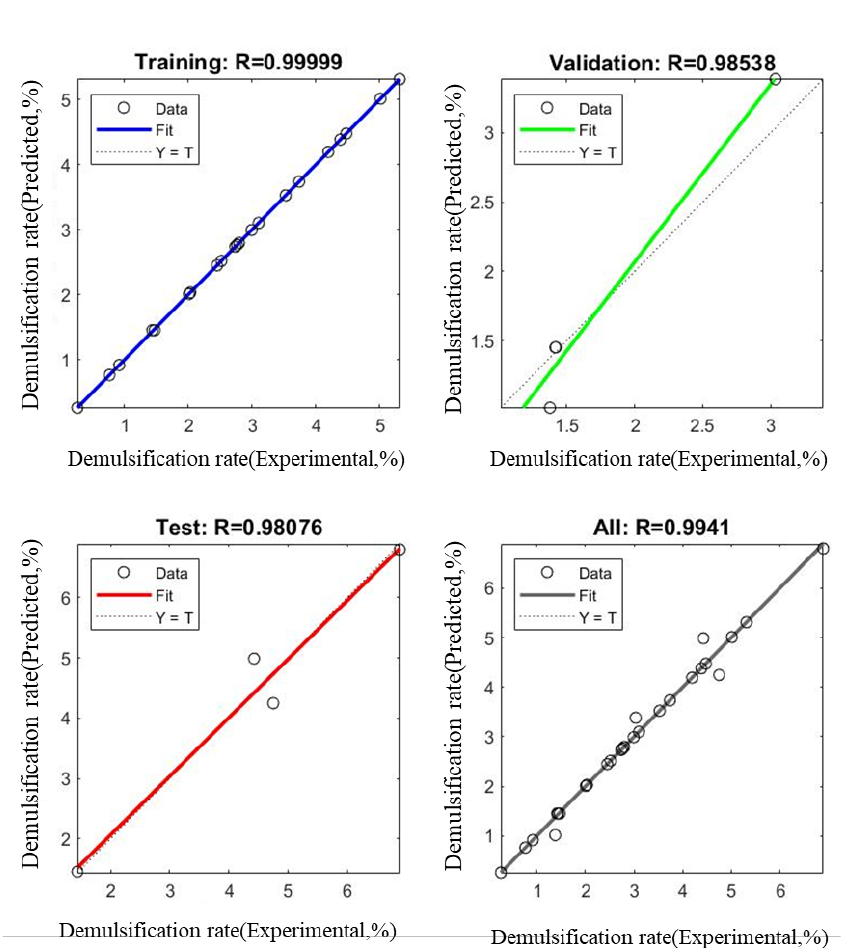
Figure 5. Regression diagram of ANN model with 10 hidden layer neurons. Table 5. Experimental value of the demulsification rate of the emulsion film and the predicted value of the RSM and ANN models.